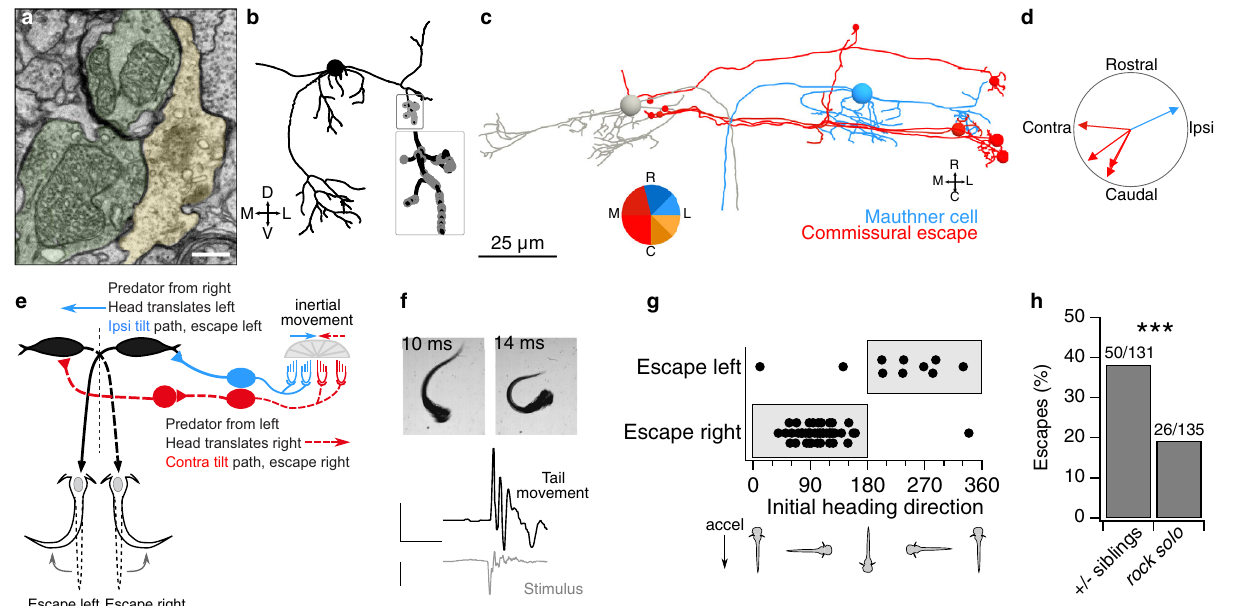
Fig.3|Escapecircuitscomputeheadmovementdirectionfromutricularinput. a Example micrograph of utricular afferents (pseudocolored green) synapsing onto the lateral Mauthner cell dendrite (yellow). Chemical synapses are recog- nizable by clustered presynaptic vesicles and synaptic density. The tight appo- sitionbetweentheupperafferentandtheMauthnerislikelyanelectricalsynapse. Scale bar, 0.5 µ m. b Coronal projection of Mauthner cell skeleton reconstruction (black, spherical soma) with utricular afferent input synapses (gray). Inset, expanded view of utricular inputs. c Horizontal projection of reconstructions of both Mauthner cells (gray, blue) and four commissural utricular neurons (red). Commissural utricular neurons make synaptic contacts on the contralateral Mauthner (small red circles). Colors indicate inferred directional tuning. d Polar plot of inferred direction tuning of utricular input to Mauthner cell and four commissural escape neurons. Directional tuning is indicated in the context of head tilt. Note that as inertial sensors, otoliths are equally sensitive to head translation in the opposite direction ( e.g ., ipsilateral head tilt and contralateral translation are indistinguishable). e Schematic of predicted Mauthner cell com- putation of head translation. A predator approaching from the right will cause a head de fl ection to the left. De fl ection of the utricular otolith by inertia